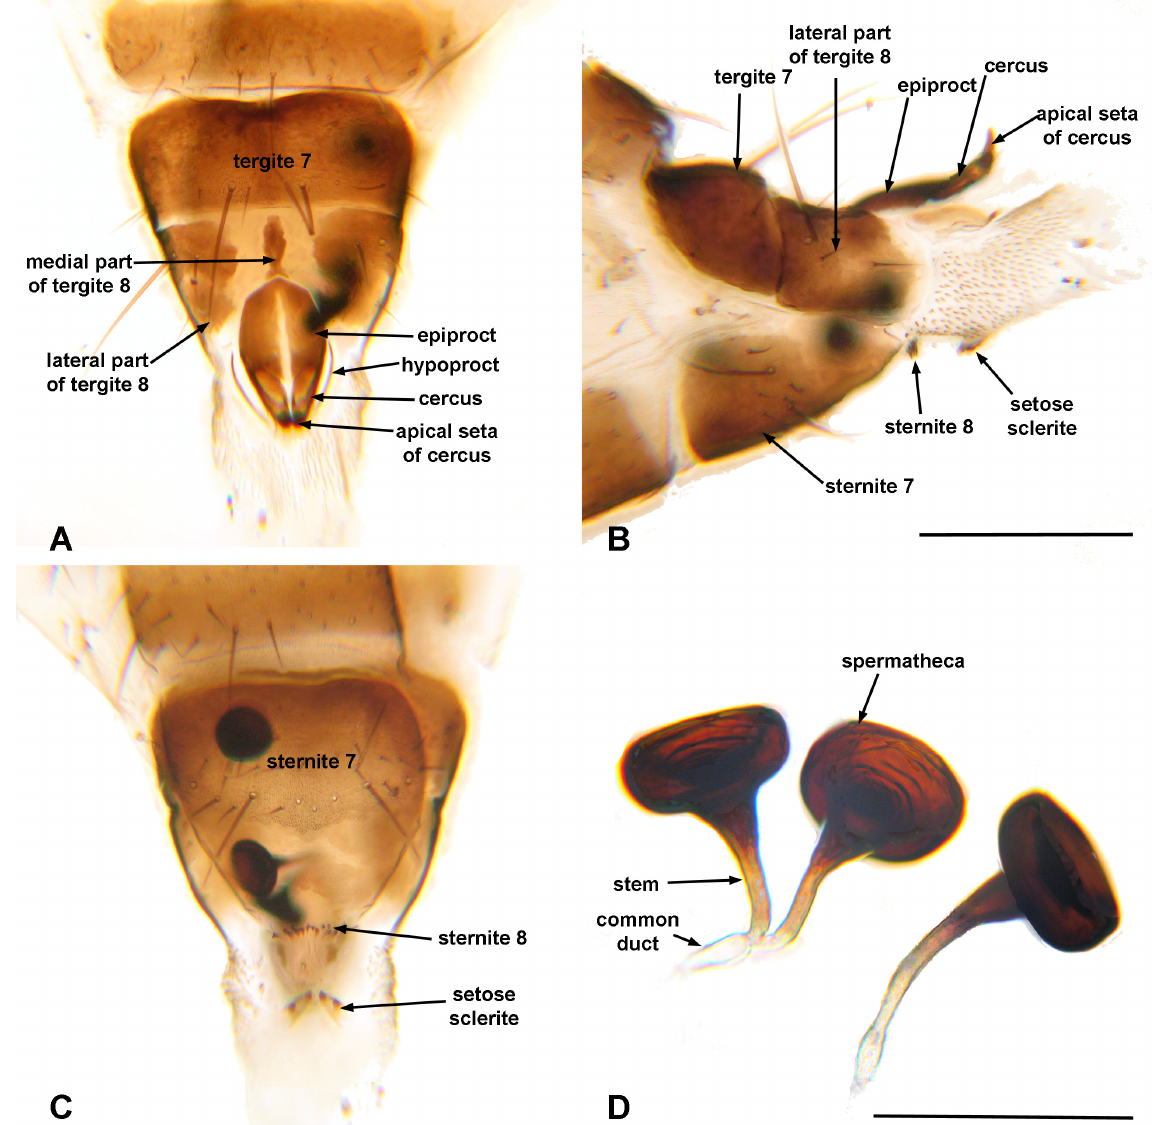
Fig. 4 . Rudolfina megepandria sp. nov., female terminalia (debu01086086). A . Terminal abdominal segments, dorsal view. B . Same as preceding, lateral view. C . Same as preceding, ventral view. D . Spermathecae. Scale bars: A–C = 0.20 mm; D =